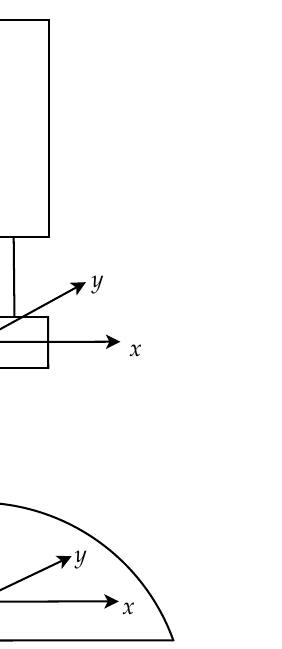
Figure 3. The coordinate frame of the catadioptric camera system used to represent the robot motion.